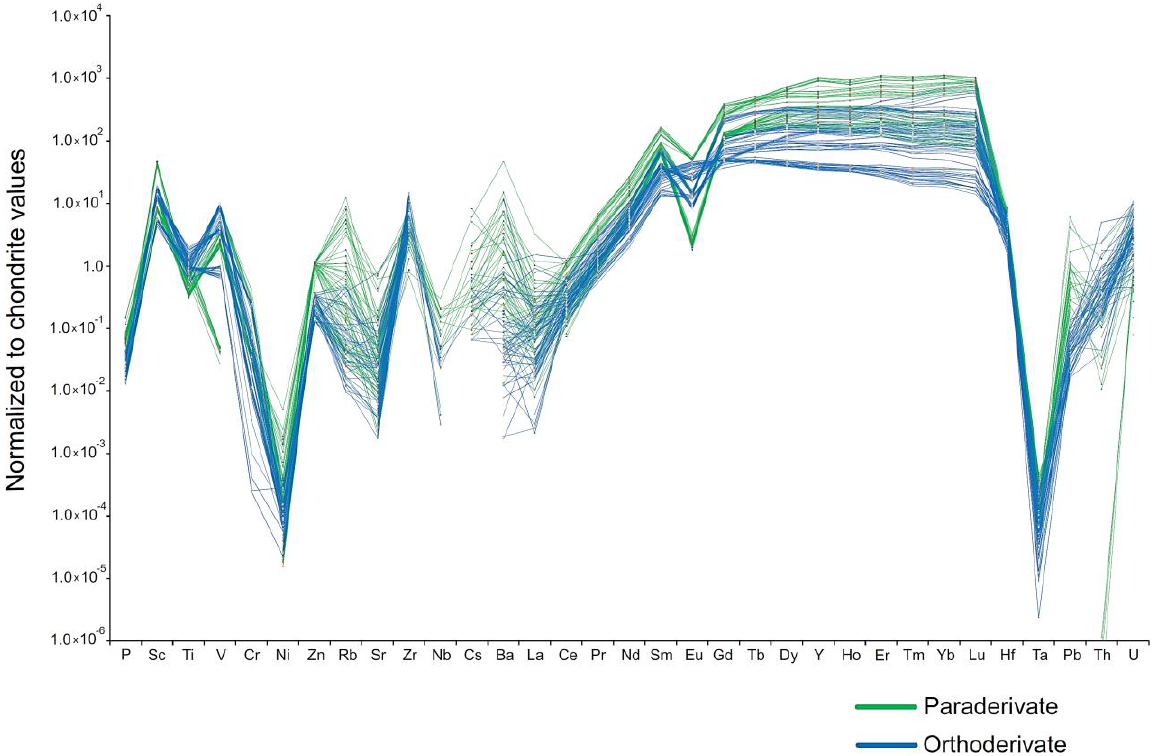
Figure 7. Minor and trace element patterns normalized to the chondritic reservoir (CHUR, [44]) of southwestern Oaxacan Complex Grts. The green pattern represents Grts from paraderivate samples and, the blue pattern represents Grts from orthoderivate samples.